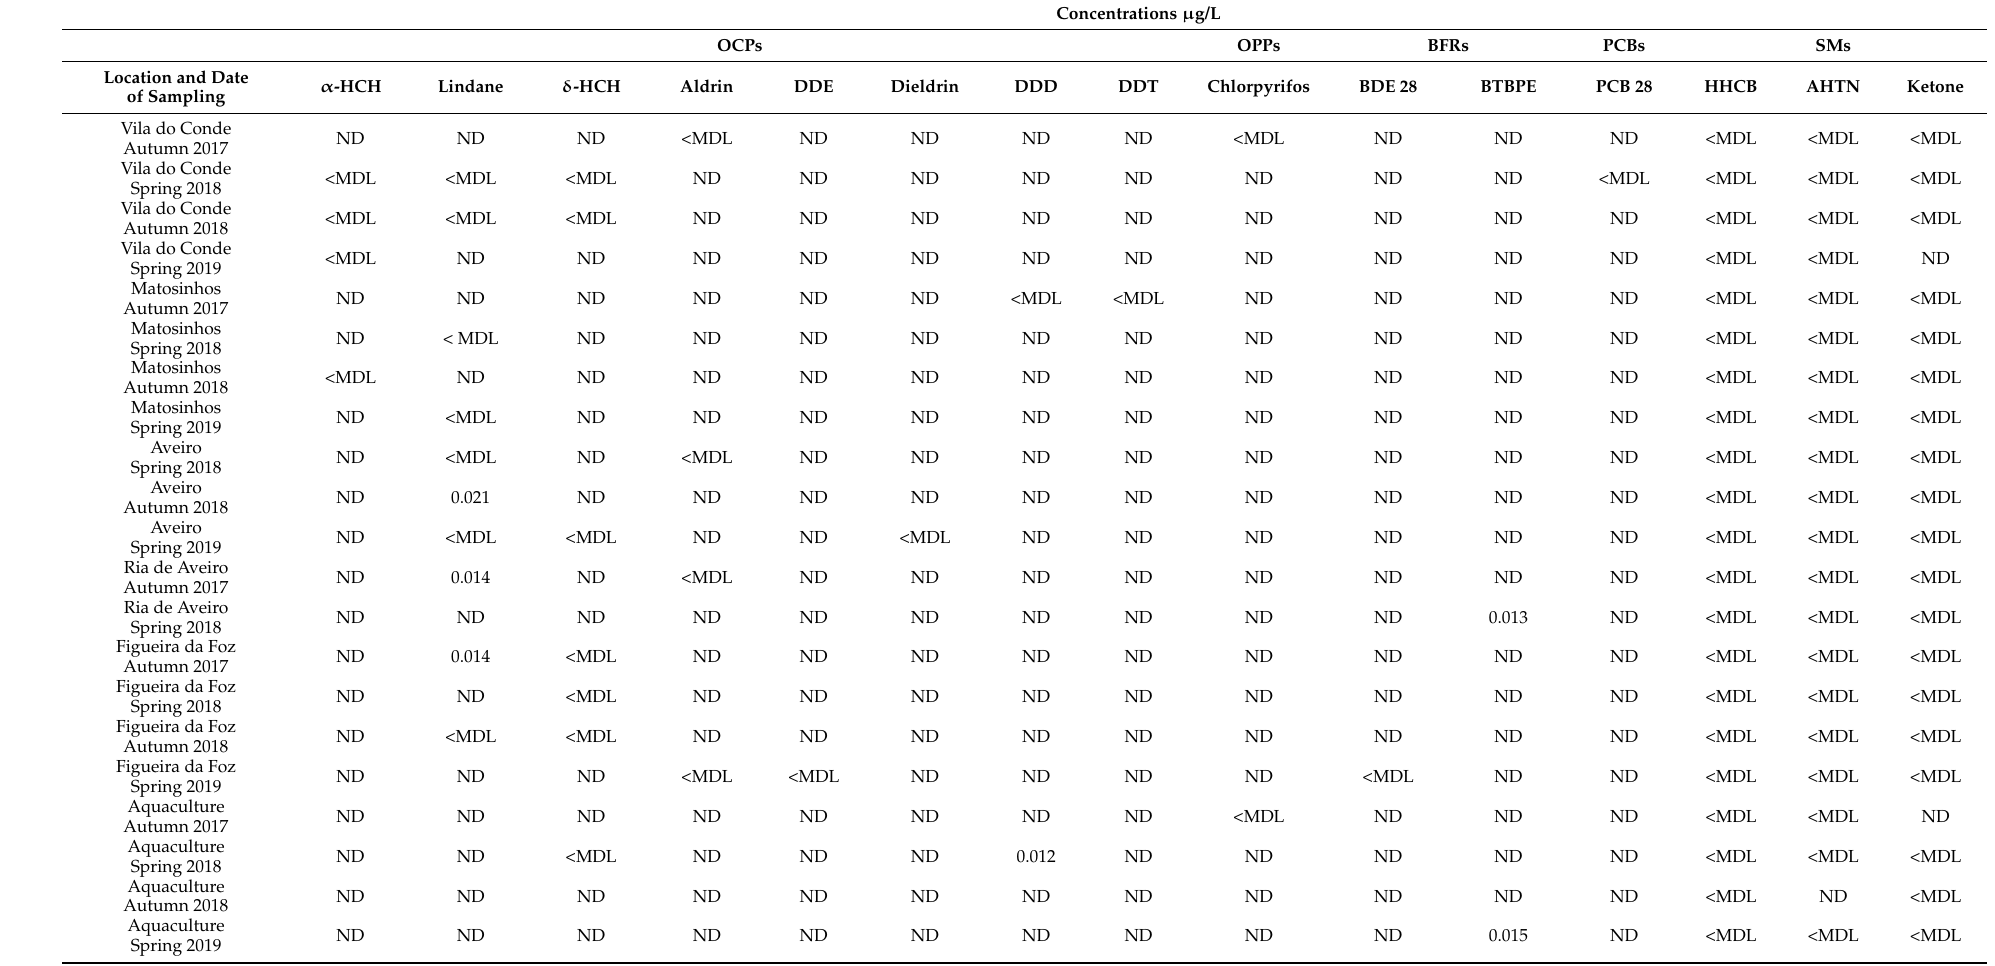
Table 1. Levels for the pollutants found in water sampled in the shrimps’ habitat ( µ g/L) from NW Portuguese coast; ND: not detected.